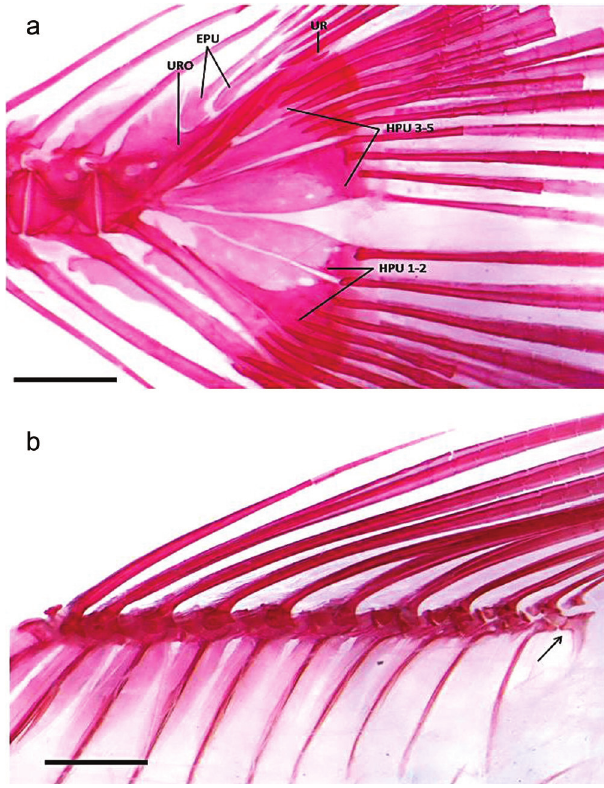
Fig. 8. Caudal skeleton, lateral view (a) and dorsal-fin pterygiophores and rays, lateral view (b) of Probolodus sazimai , MCP 13813, paratype, 43.5 mm SL. EPU: epurals, HPU 1-5: hypurals, UR: uroneurals, URO: urostyle. Scale bars = 1